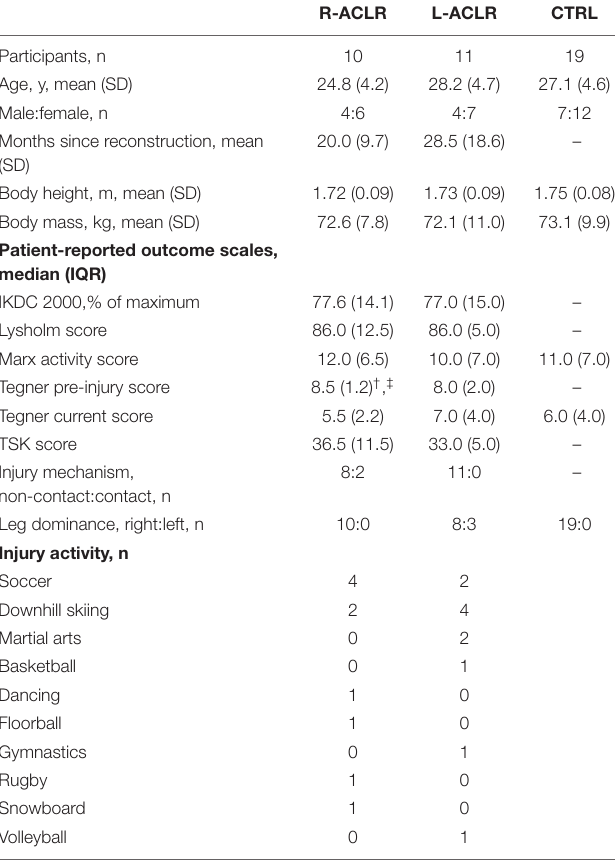
TABLE 1 | Participant characteristics of the study